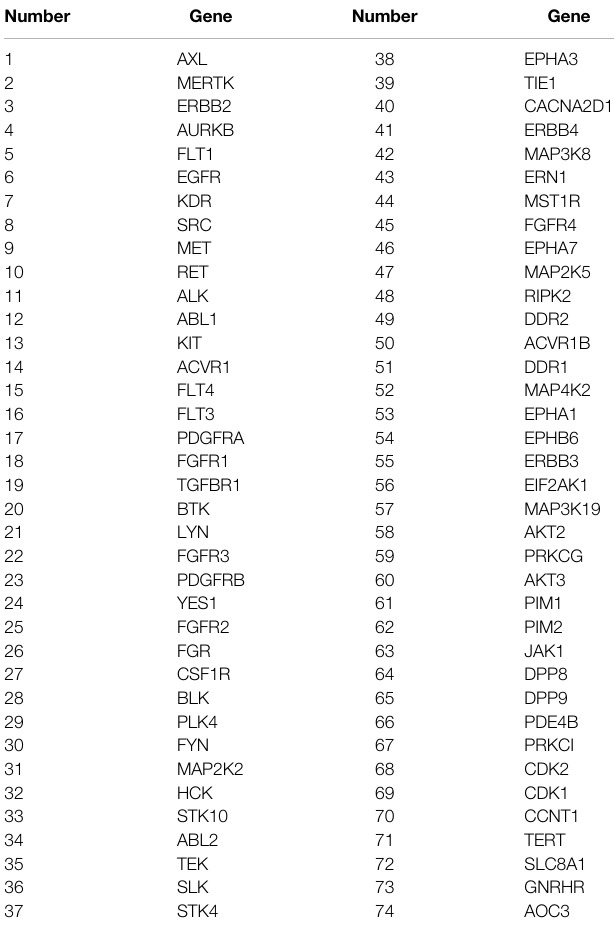
TABLE 4 | Common targets shared between the potential anlotinib targets and lung fi brosis-related